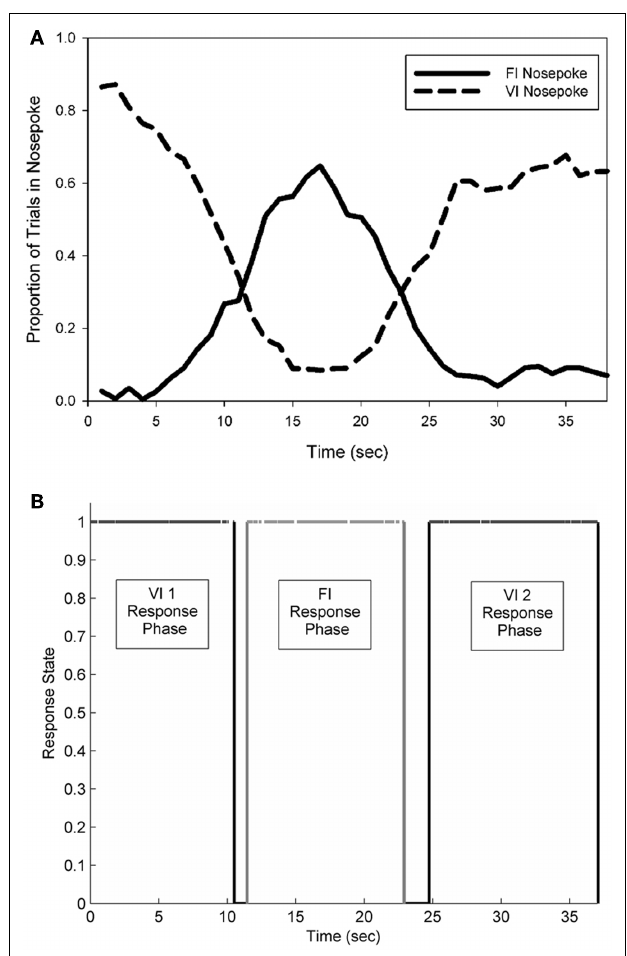
FIGURE 3 |A representative example of the average pattern of responding from a single rat observed during an electrophysiological recording session (A). FI nosepoke responses formed a near-symmetrical peak distribution, centered near 15s, while two separate periods of responding occurred on theVI nosepoke. (B) Depicts the pattern of responding observed in an individual probe trial. Black lines indicate occupancy in theVI nosepoke, and grey lines indicate occupancy in the FI